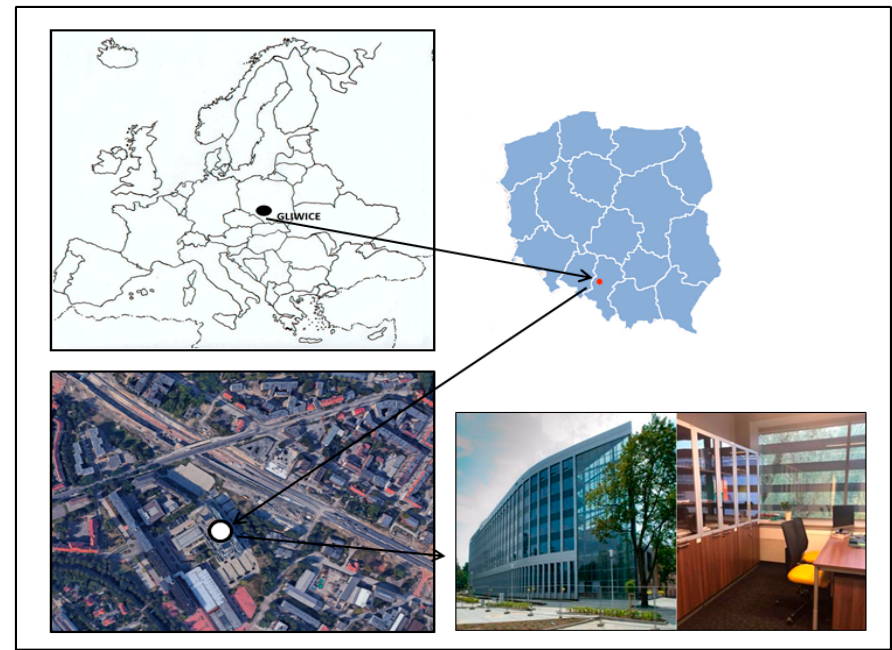
Figure 1. Sampling site location (Map data: 2017© Google, ORION-ME;